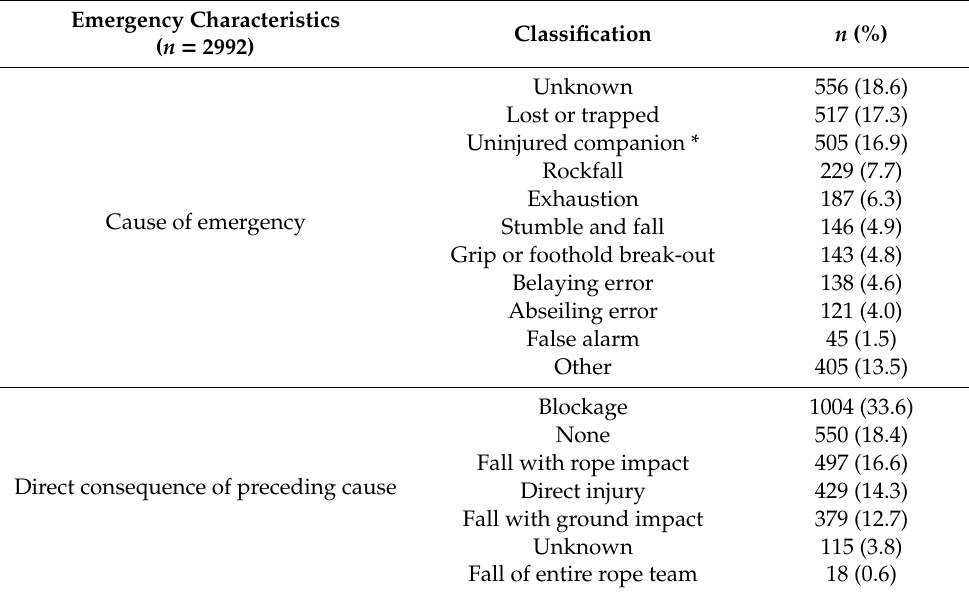
Table 1. Characteristics of rock climbing emergencies in Austria from 2005 to 2018, ranked according to frequency.